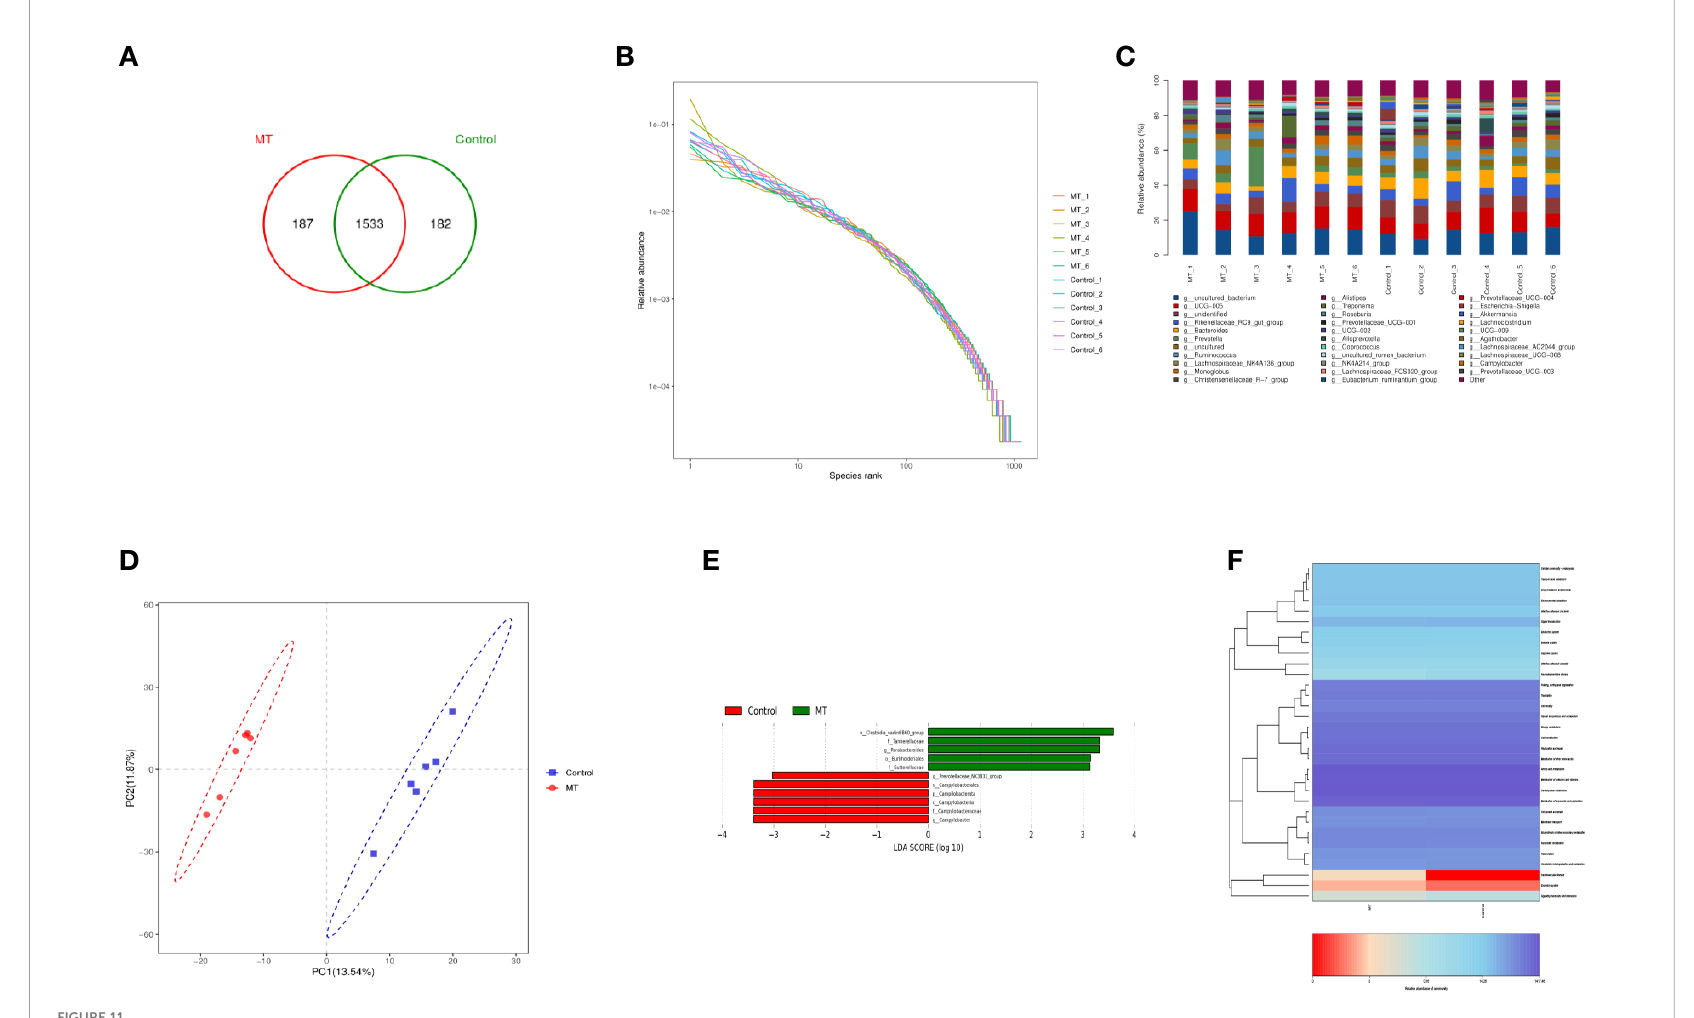
FIGURE 11 Sequencing analysis of gut microbiota. (A) Venn diagram; (B) Rank abundance diagram; (C) Histogram of genus-level species composition analysis; (D) OTU-based partial least squares discriminant analysis; (E) LDA distribution of LEfSe analysis based on taxonomic information Histogram; Species with differences in LDA score greater than 3, species with signi fi cant differences in abundance in different groups, the length of the histogram represents the impact size of signi fi cantly different species; (F) PICRUSt predicted differential pathway heat map